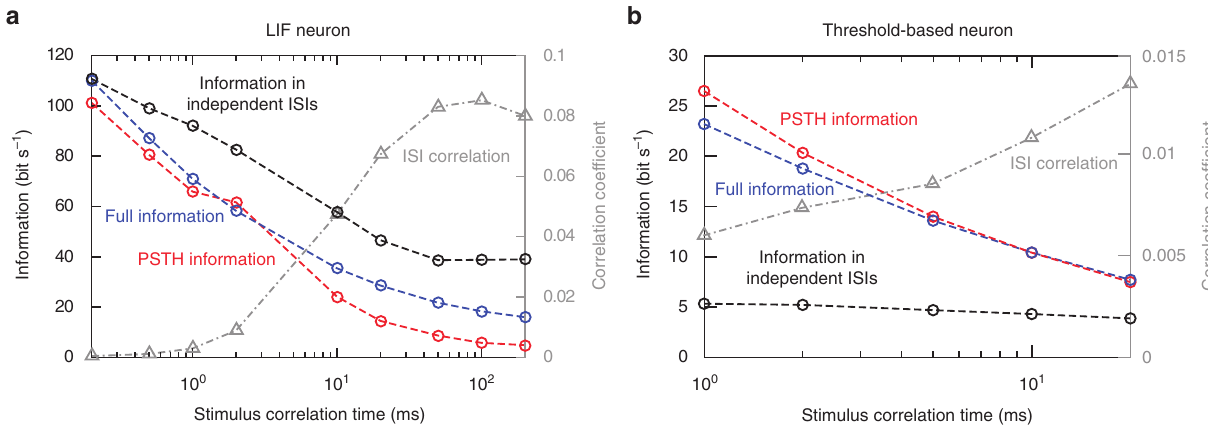
Figure 5 | Temporal spike interactions impact neural information content. ( a ) The full information content predicted by the correlation theory (blue circles) along side the ISI information (black circles) and the Poisson rate approximation via PSTH (red circles) for a leaky integrate-and-fire neuron firing at 50Hz. For reference, we also include in grey the correlation coefficient between successive interspike intervals. ( b ) The analogous quantities as in a for the threshold-based neuron firing at 5Hz. Considering the PSTH-based Poisson rate approximation of information (red circles) results in an underestimation for slow stimuli in a and overestimation for fast stimuli in b . In a , b , we observe that temporal correlations can have two opposite effects, they can either increase the information by 4 50% ( a ) or decrease it ( b ) by a similar factor. To exclude firing rate effects as we vary time constants in a , b , we adjusted the spiking threshold to maintain a constant firing rate across all time constants. We further set t stim ¼ t noise , t mem ¼ 10ms, other parameters in as in Table 1. Methods to ensure convergence of the ISI information can be found in the Supplementary Note 2 and Supplementary Fig. 4.